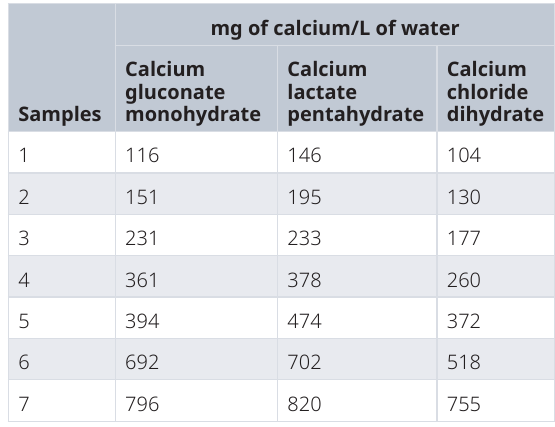
Table 1. Calcium concentrations for each salt tested in the triangle